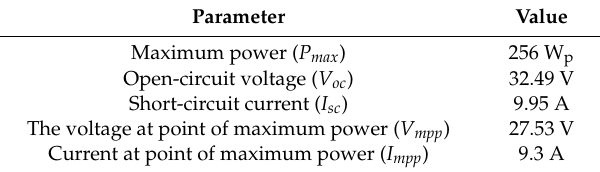
Table 7. Specifications of the photovoltaic (PV) modules at standard test conditions (STC).